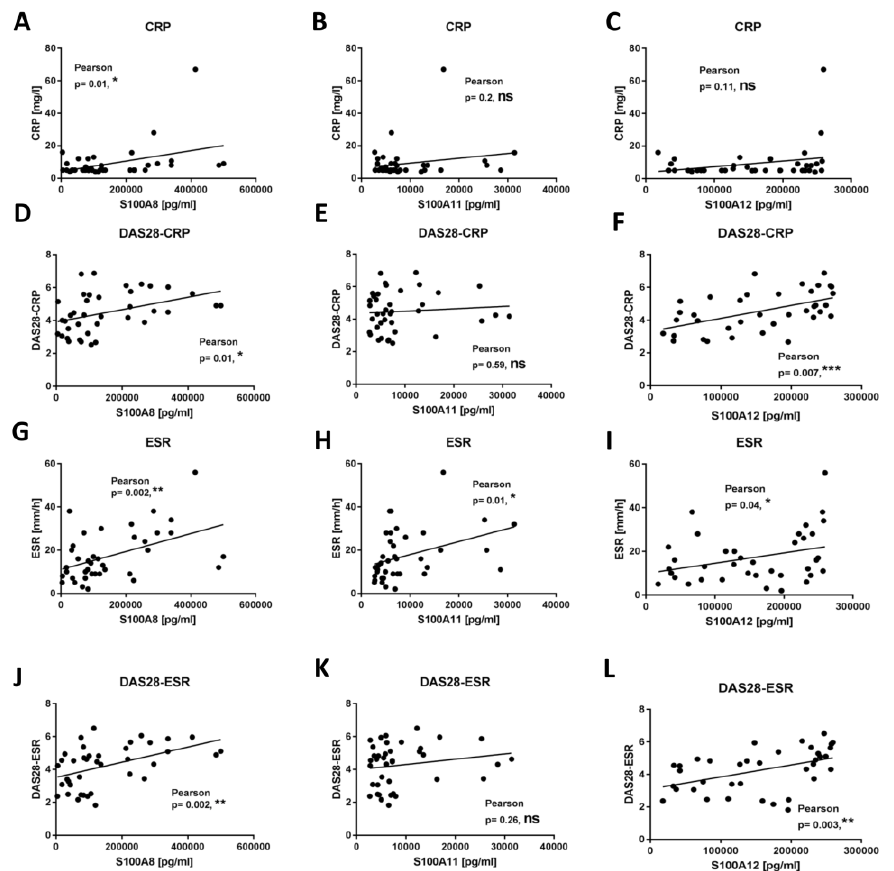
Figure 4. Correlation of S100A8, S100A11, and S100A12 proteins with clinical parameters: The levels of the S100A8 protein were measured in sera and correlated with clinical parameters — including CRP ( A ), DAS28-CRP ( D ), ESR ( G ), and DAS28-ESR ( J ) — in RA patients ( n = 39). The levels of the S100A11 protein were measured in sera and correlated with clinical parameters — including CRP ( B ), DAS28-CRP ( E ), ESR ( H ), and DAS28-ESR ( K ) — in RA patients ( n = 39). The levels of the S100A12 protein were measured in sera and correlated with clinical parameters — including CRP ( C ), DAS28-CRP ( F ), ESR ( I ), and DAS28-ESR ( L ) — in RA patients ( n = 37). p values were expressed as follows: 0.05 > p > 0.01 as *, 0.01 > p > 0.001 as **,0.001 > p > 0.0001 as *** and ns — not significant.